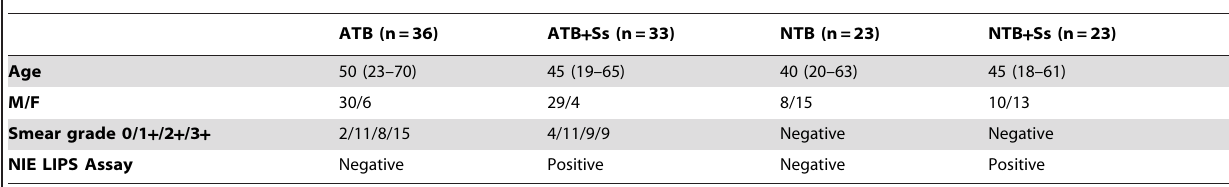
Table 1. Study demographics.